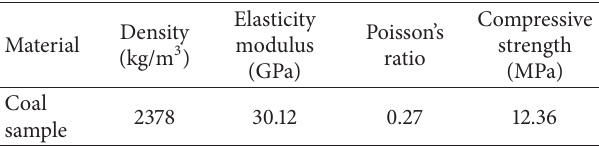
Table 1: Parameters of